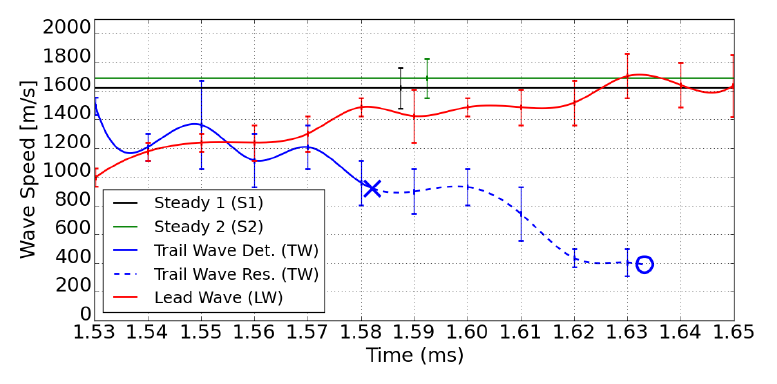
Figure 13. Trailing, leading, and steady wave speeds in